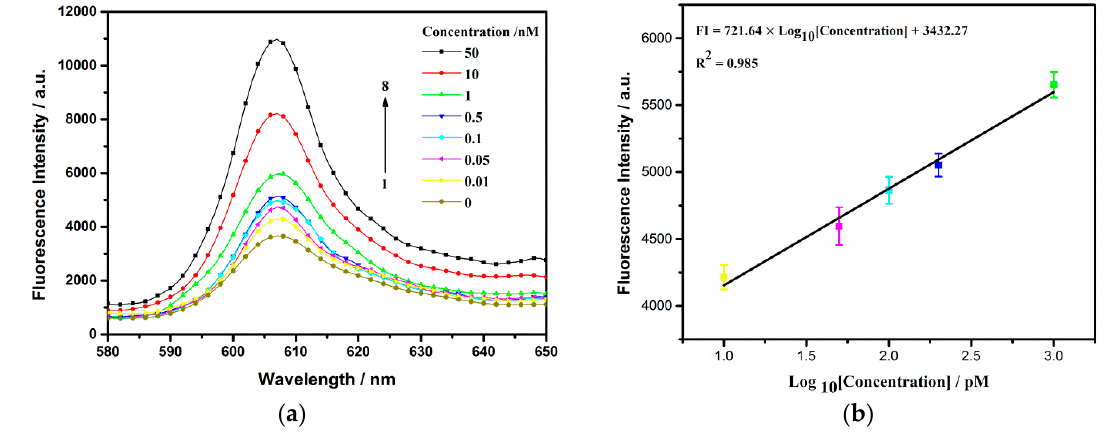
Figure 8. ( a ) Florescence spectra of NMM with different concentrations of thrombin. From curve 1 to 8, the concentration of thrombin is 0, 0.01, 0.05, 0.1, 0.5, 1, 10, 50 nM, respectively; ( b ) Liner correlation of the fluorescence change vs logarithmic concentration of thrombin. The standard errors of slope and intercept are 43.39 and 91.40, respectively. Error bars show the standard deviation of three experiments. Table 2. Comparison of the methods with the previous fluorometric/colorimetric for thrombin detection.